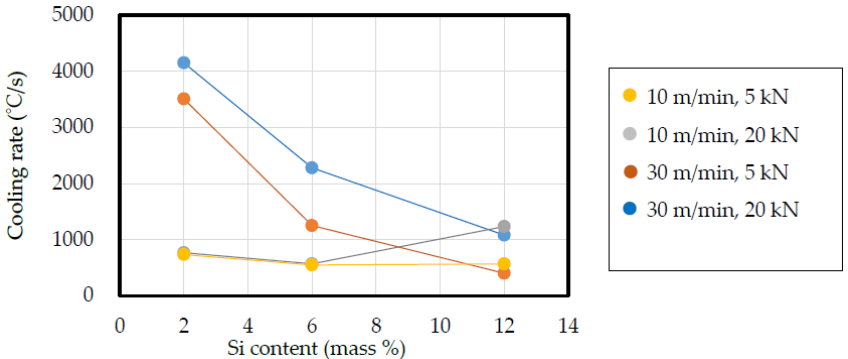
Figure 8. Effects of roll speed, roll load, and Si content on cooling rate for Al-Si alloy. Roll speed: 10 m/min and 30 m/min; roll load: 5 kN and 20 kN; Si content: 2%, 6%, and 12%.